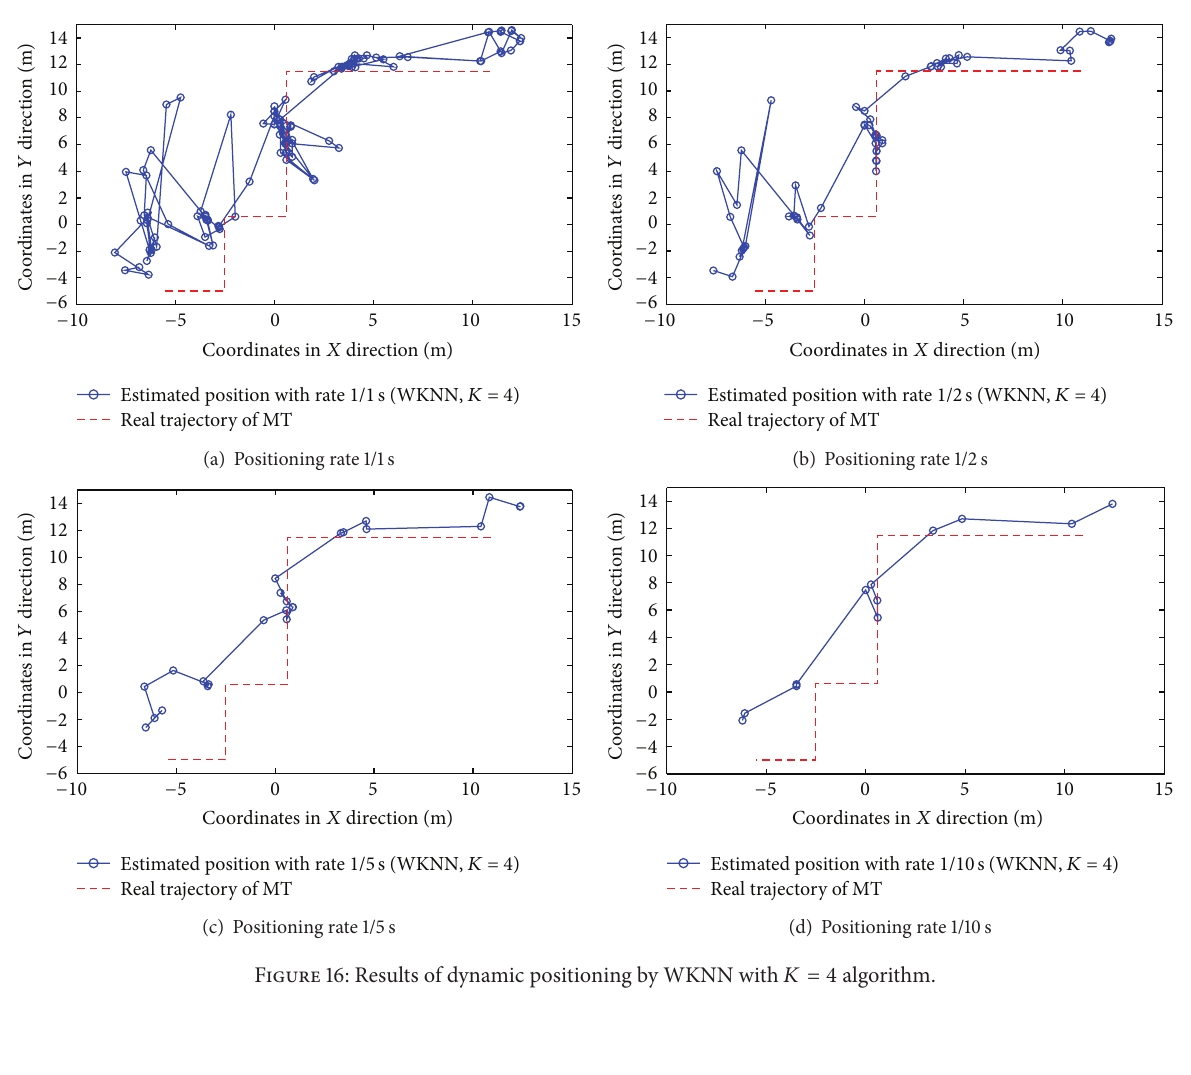
positioning rate 1/10 s); (ii) time cost for the selection of the parameters corresponding to the smallest statistical error based on the coarse positioning results; (iii) time cost for searching neighbor(s) in radio map; and (iv) time cost for the calculation of the target’s estimated position. The time cost for each position calculation by RADAR neighbor